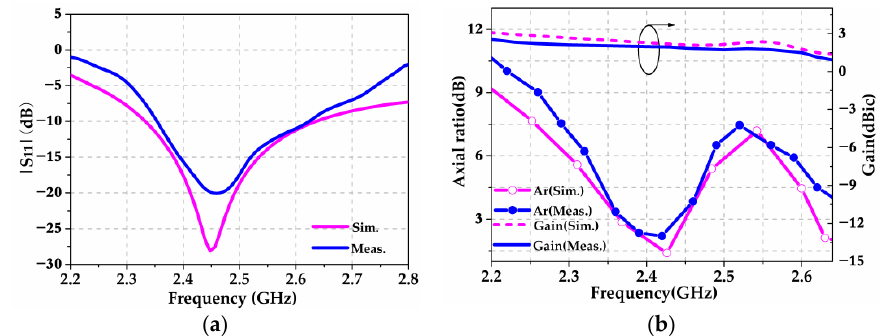
Figure 23. Simulation and measurement results of State-V: ( a ) | S 11 |; ( b ) AR and gain. Electronics 2020 , 9 , 873